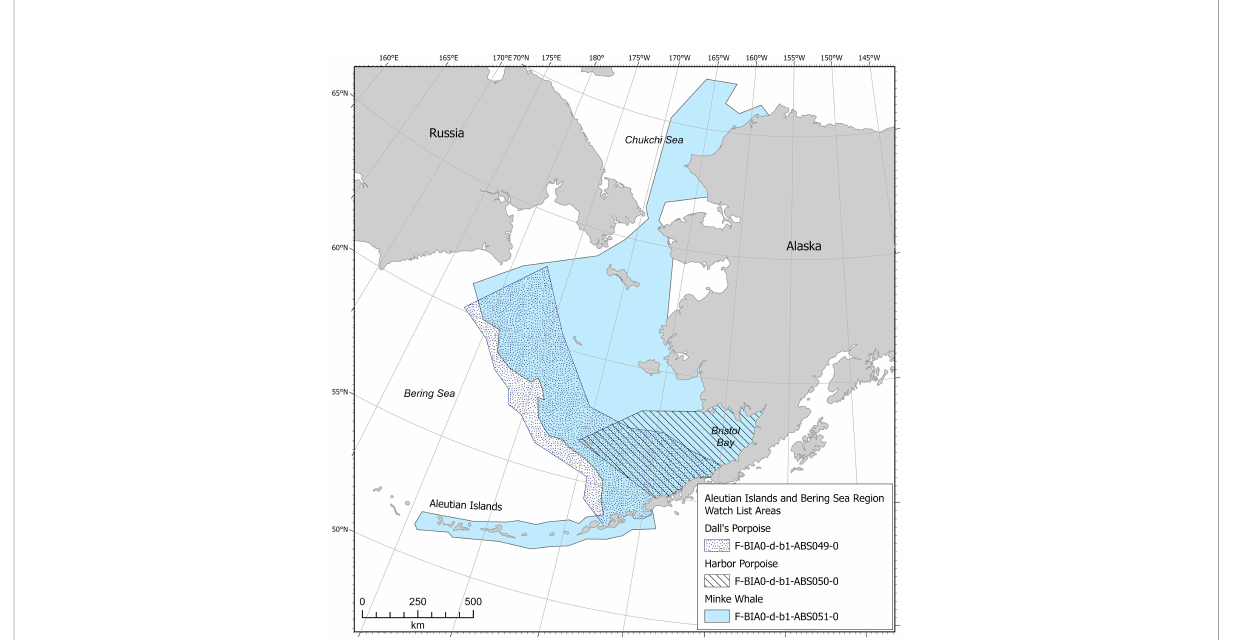
FIGURE 12 Aleutian Islands and Bering Sea region minke whale, harbor porpoise, and Dall ’ s porpoise watch list